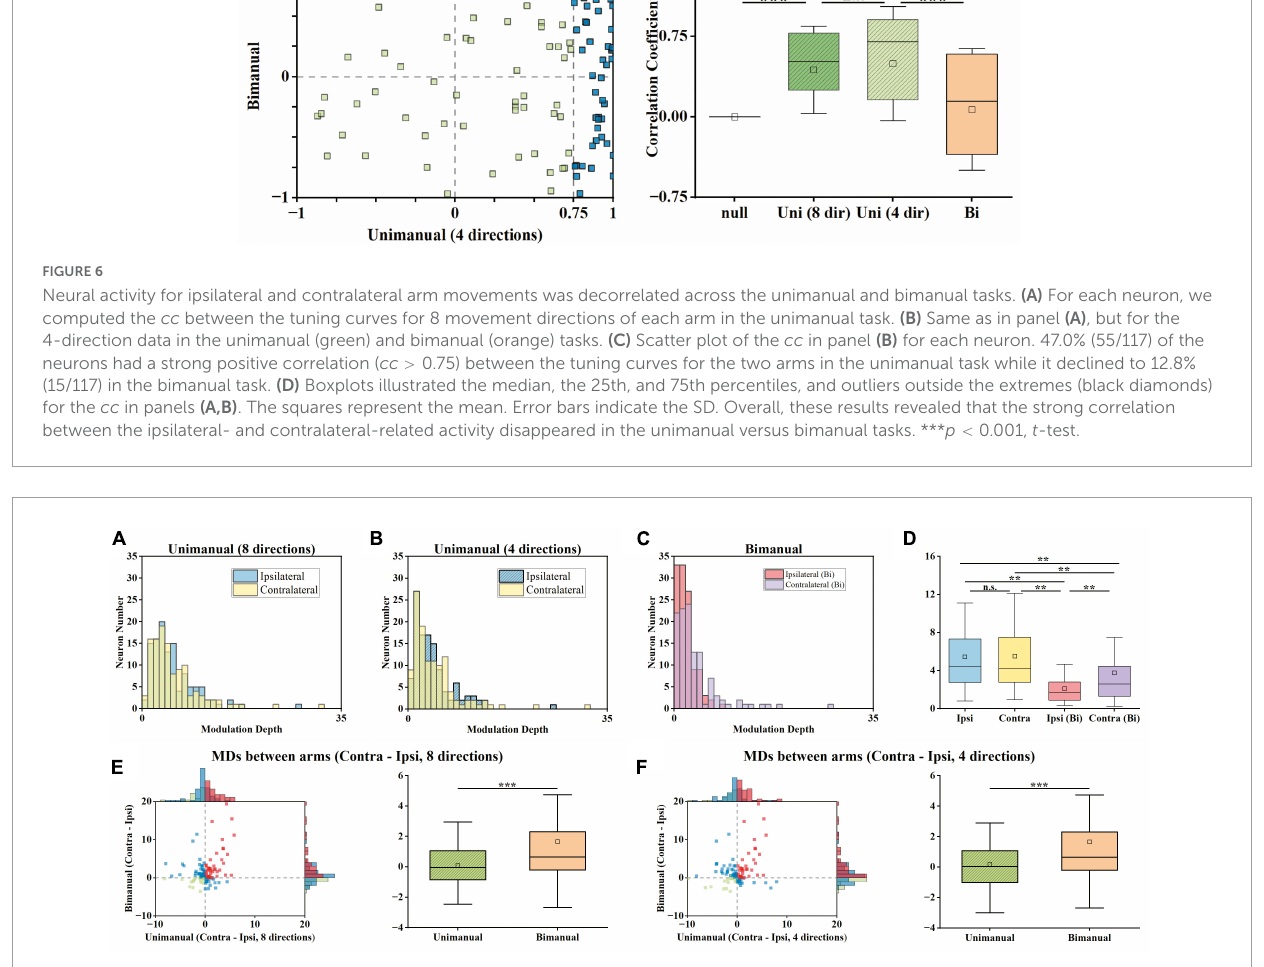
and showed that the number of neurons with a larger contralateral MD had a substantial increase (59 versus 79 among the 117 neurons for unimanual-4-direction versus